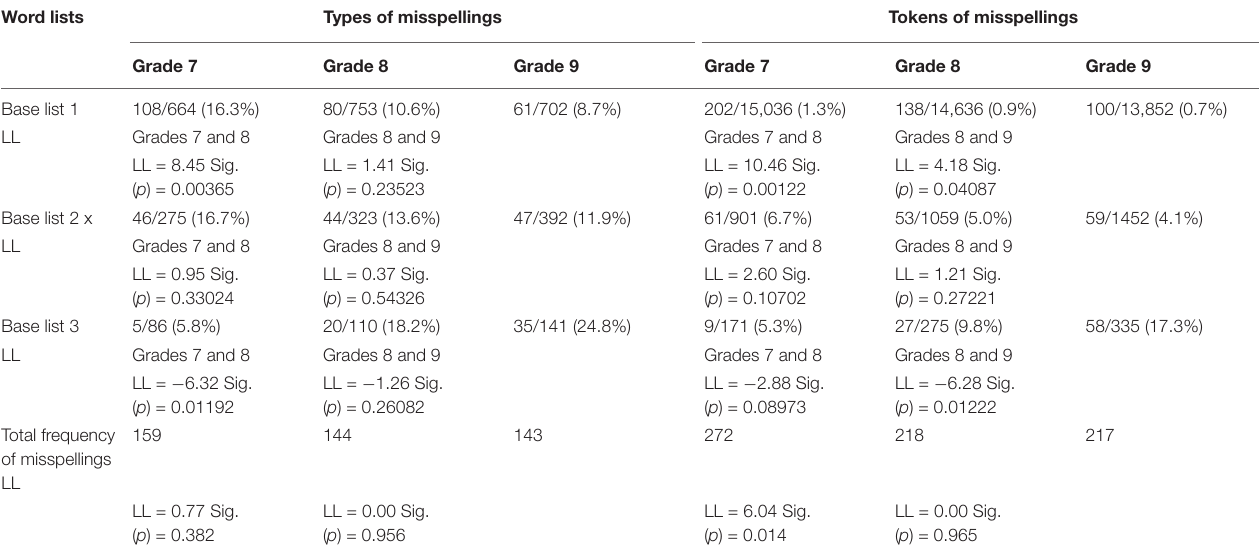
TABLE 9 | Percentage of misspellings per base list and per grade